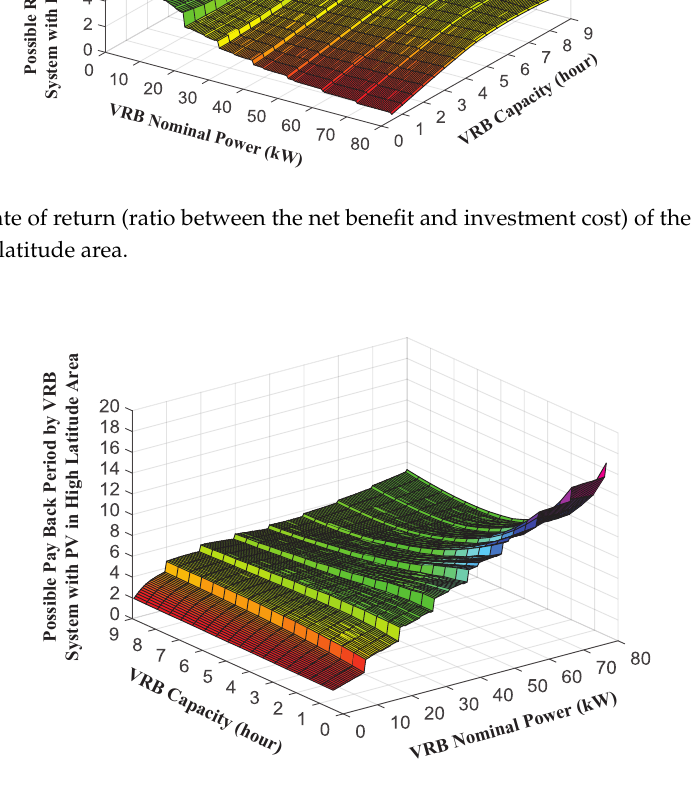
Figure 18. Payback period of the VRB system with PV in a high latitude area